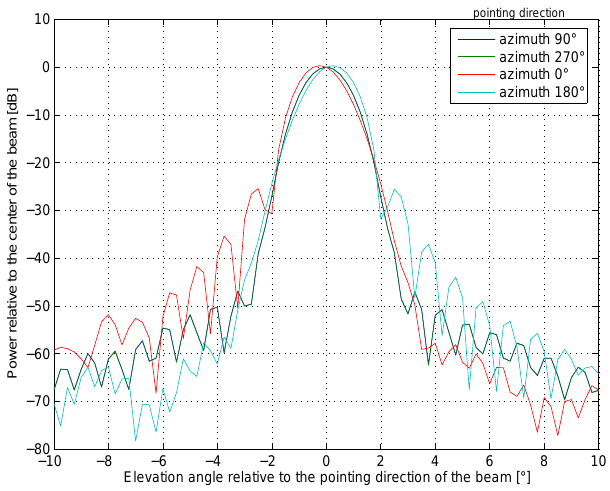
Fig. 6. Radiation pattern of the entire optical system in the eleva- tional dimension for different positions of the slewable mirror, cal- culated with physical optics.